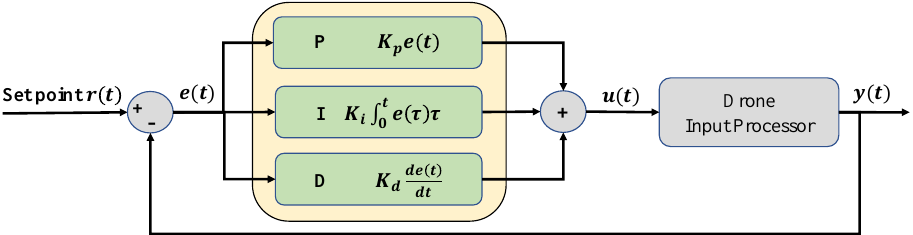
Figure 2. The basic PID controller. The error term e t is the difference between the desired position r ( t ) and the sensed position y ( t ) . Each PID term is computed based on the current and past errors. The force of each rotor is computed from Equations (4) and (6). After processing the input, we have the current output y ( t ) . This feedback loop decreases e t gradually.